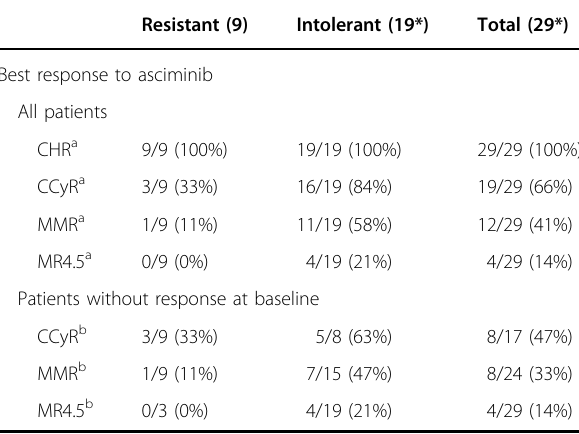
Table 2 Response to asciminib subanalysis regarding baseline